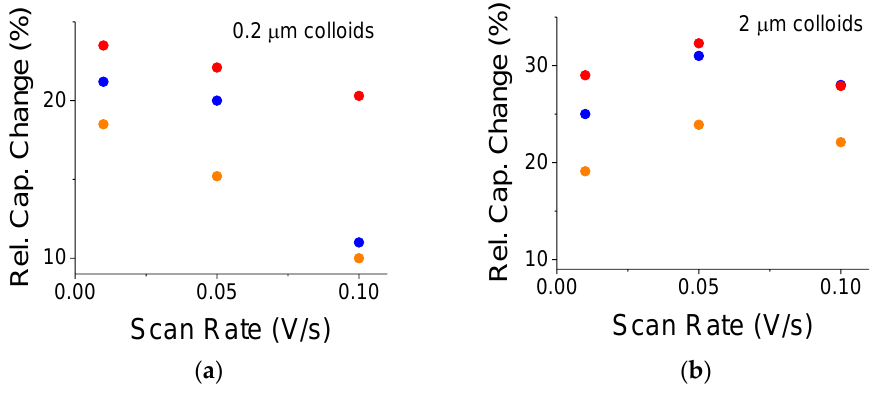
Figure 7. Comparison between relative capacitance changes, (C light ON − C light OFF )/C light OFF , as a function of scan rate for various illumination conditions. Red, yellow, and blue dots represent illumination, respectively, without a filter, through a yellow filter, and through a blue filter. ( a ) For embedded 0.2 μ m colloids. ( b ) For embedded 2 μ m colloids. The white light source was a 300 W incandescent lamp.